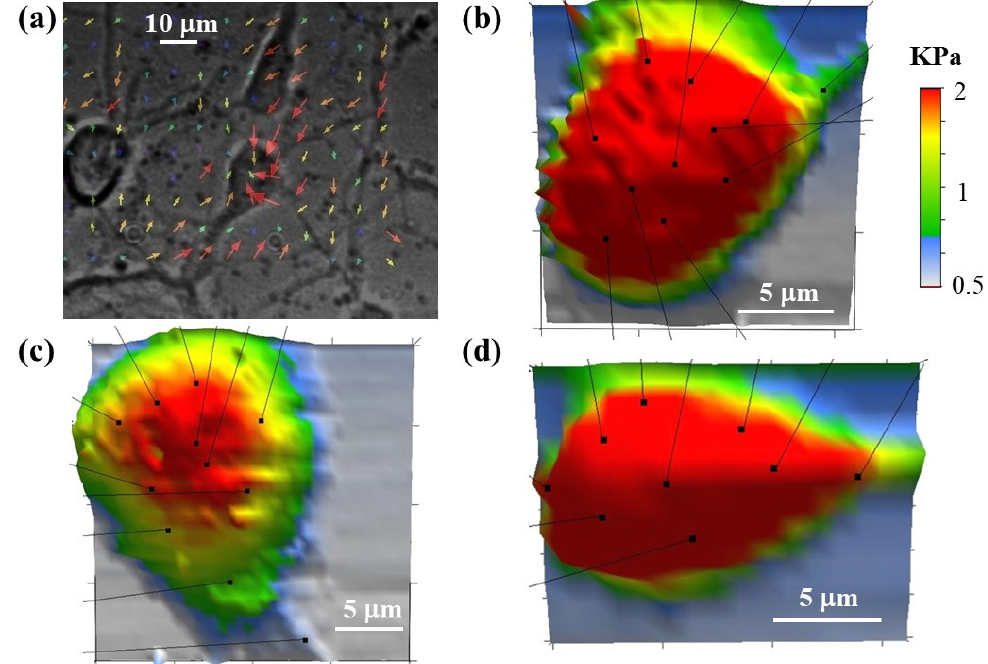
Figure 7. ( a ) Traction Force Microscopy image for three cortical neurons cultured on a PAA substrate with Young’s modulus E S = 470 Pa. The arrows show the displacement field 𝑢(cid:4652)⃗ . The size of the arrow at each point is equal to the magnitude of the displacement at that point; ( b – d ) examples of 3D elasticity maps measured by AFM for three neuronal cells. The arrows in each figure show the points of maximum coupling between the cell and the growth substrate. The stiffness scale bar shown in ( b ) is the same for all AFM images.